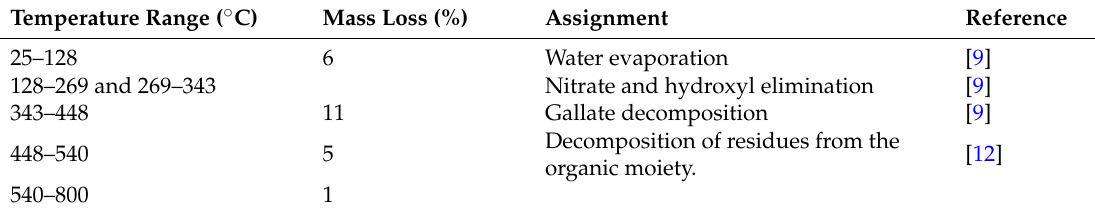
Figure 4. Thermogravimetric analysis and differential scanning calorimetry (TGA and DSC) patterns of the LDH ‐ gallate product obtained in isopropanol under nitrogen atmosphere. Table 1. Ranges of decomposition events observed in the thermogravimetric analysis (TGA) profile.